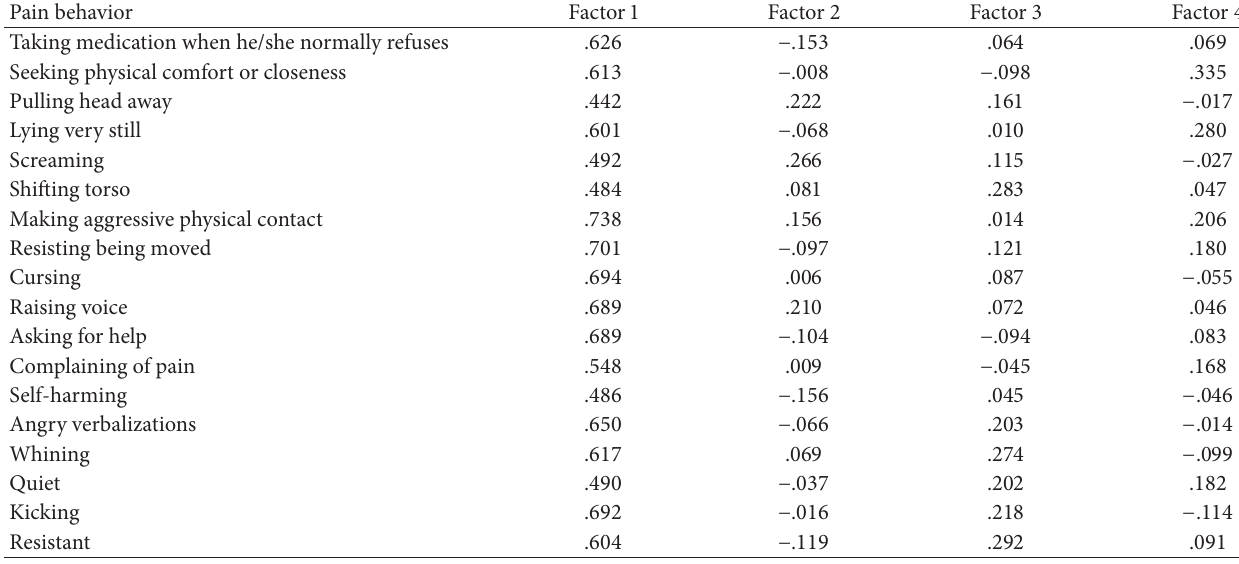
Table 1: Final list of pain behaviors extracted from pediatric observational pain scales that loaded on factor 1, which we labeled as the “Controlled”